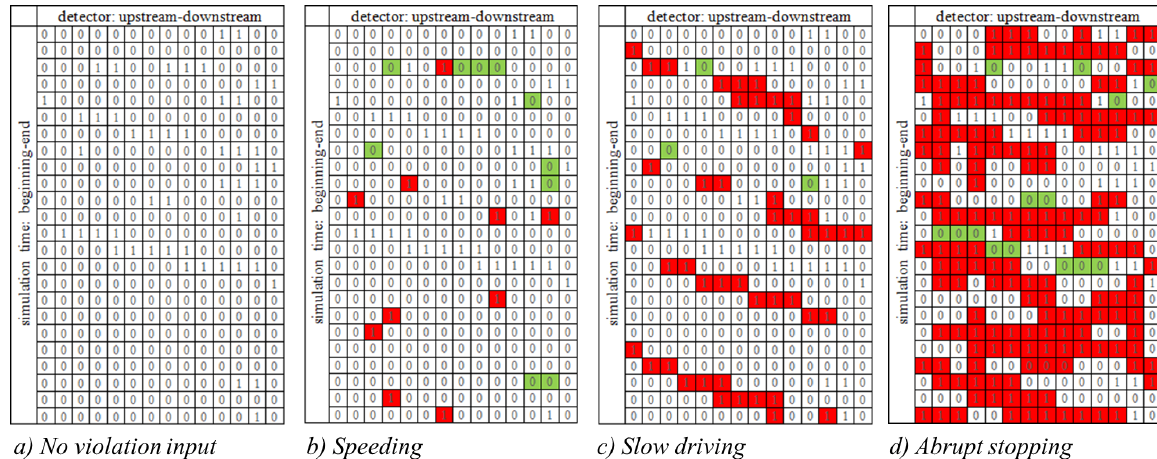
Fig 11. Space-time diagram of traffic flow risk for different violation